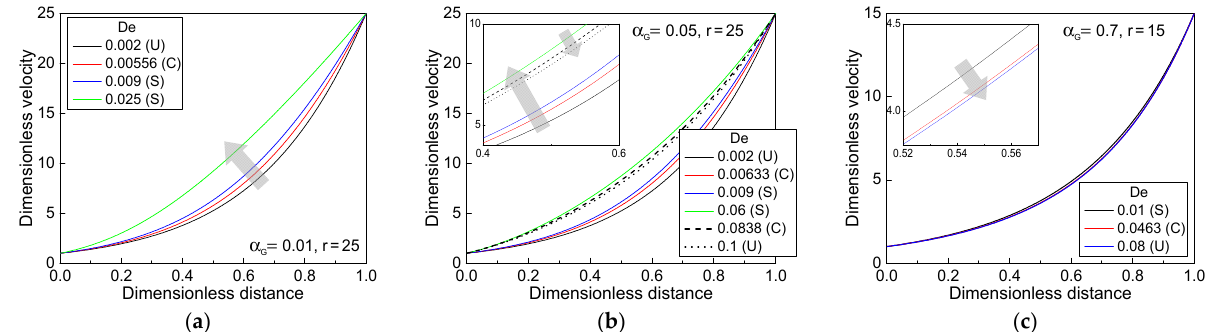
Figure 3. Dimensionless steady spinline velocity profiles under several material parameter conditions: ( a ) α G = 0.01, r = 25, ( b ) α G = 0.05, r = 25, and ( c ) α G = 0.7, r = 15. S, C, and U in the box indicate stable, critical, and unstable states, respectively. The arrow indicates the direction in which De increases.